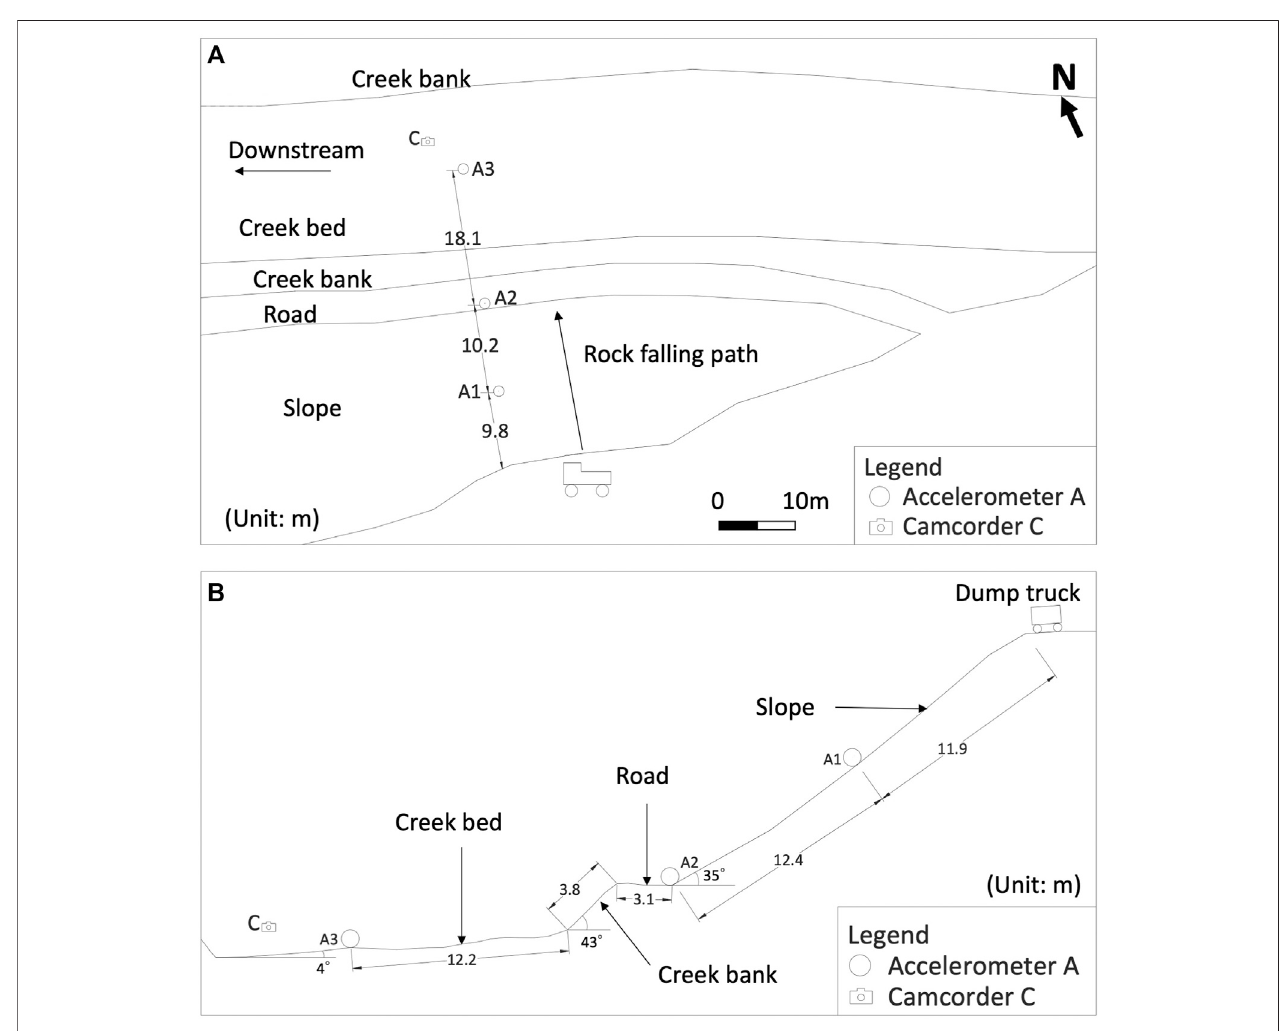
FIGURE 1 | Setup of the tests and layout of the sensors (A) top view, (B) side view (modi fi ed from Feng and Zhuang (2021)).